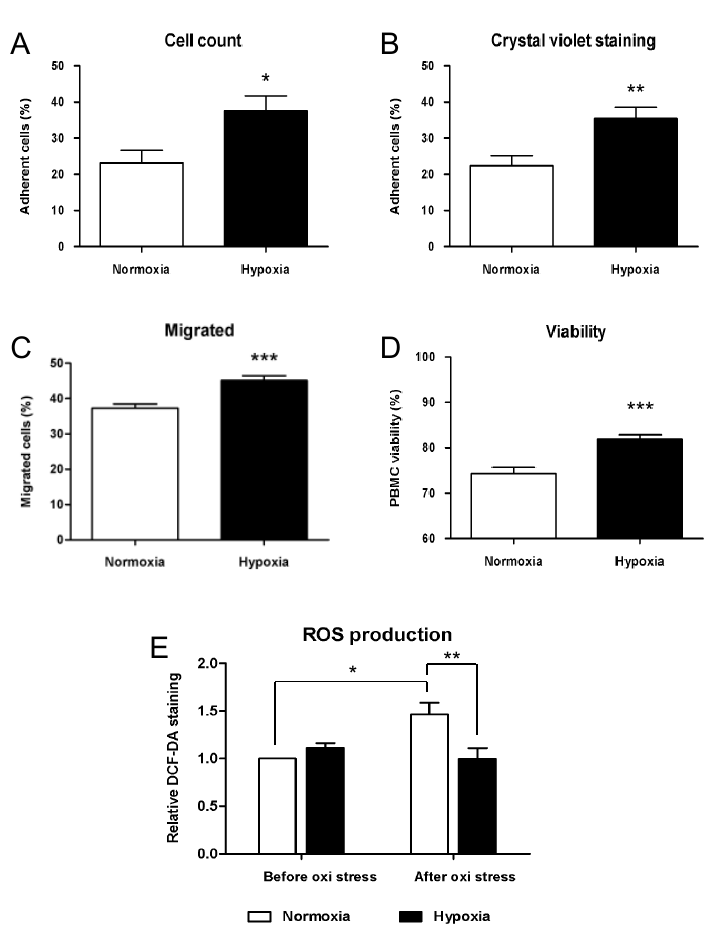
Figure 3. Functional analysis of PBMC conditioned in normoxic (control) and hypoxic environments. ( A ) Calculation of adhesion percentage by subtraction of non-adherent cells in N = 7 samples. ( B ) Measurement of adhesion percentage by crystal violet staining and colorimetric assay in N = 7 samples. ( C ) Average percentage of migrated PBMC in N = 8 samples. ( D ) Viability of PBMC before and after a 24 h incubation with 400 µM H 2 O 2 in N = 14 samples. ( E ) Relative quantification of ROS production before and after a 24 h incubation with 400 µM H 2 O 2 in N = 8 samples. DCF-DA fluorescent emission was used for quantification. Data are represented as mean ± SEM. * = p < 0.05, ** = p < 0.01, *** = p < 0.001.